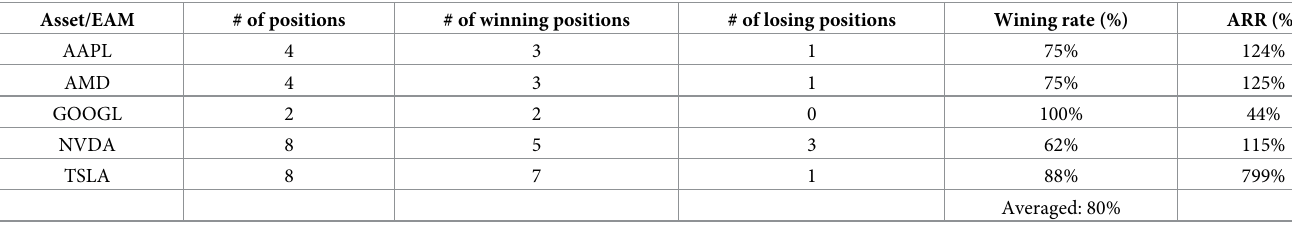
As shown in Table 5, the number of positions opened by any EAM is less than ten, and the highest is NVDA and TSLA’s eight opened positions. The most profit-making EAM is TSLA, with ARR of 799%. These results exemplify the high quality and reliability of the signals gener- ated by the EAMs. The winning rates of all the five EAMs are more than 50%. Since averaged winning rate is 80%, it indicates that even with a mediocre averaged winning rate, SAM still can efficiently utilize the information generated by the EAMs and has the outperformance compared to ARL. The results also indicate that the MSPM can perform even better if we improve the winning rate of EAMs. Table 5. Statistics of EAMs’ position-holding during year 2020. Asset/EAM